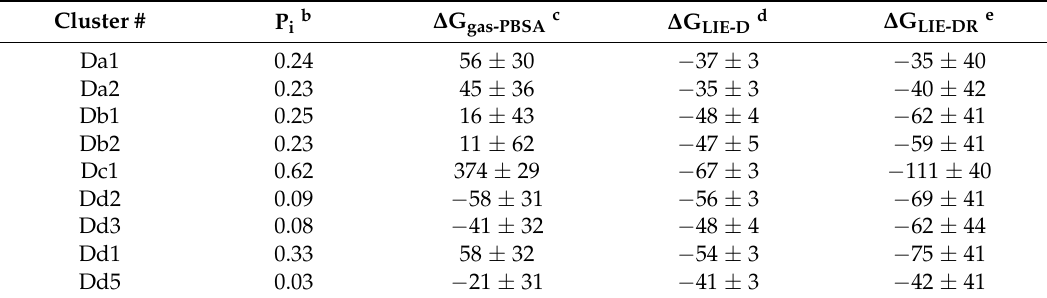
a The raw data is in Supporting information Table S3; b Fractional population; c Equation (2); d Equation (8);